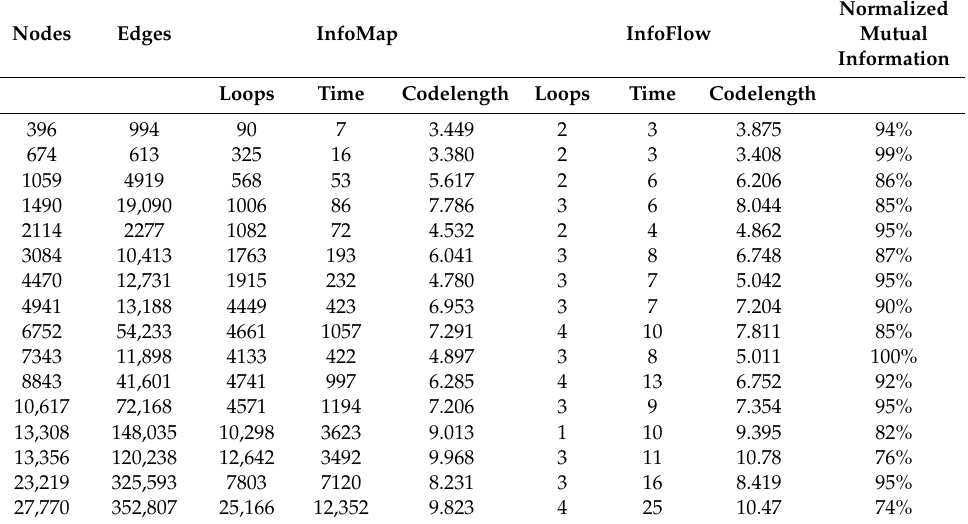
Table 1. Benchmarking results for InfoMap and InfoFlow, for datasets of various size, on the Dell Precision T3610. To aid comparison we do not include common performance runtime, including file reading time and PageRank runtime from the table. Runtime in unit of seconds. In these test cases, while runtime complexity is linear in the case of InfoMap, it is pseudo-constant in InfoFlow, while keeping very high accuracy in the final partitioning, according to normalized mutual information (NMI). The datasets are real world graphs taken from